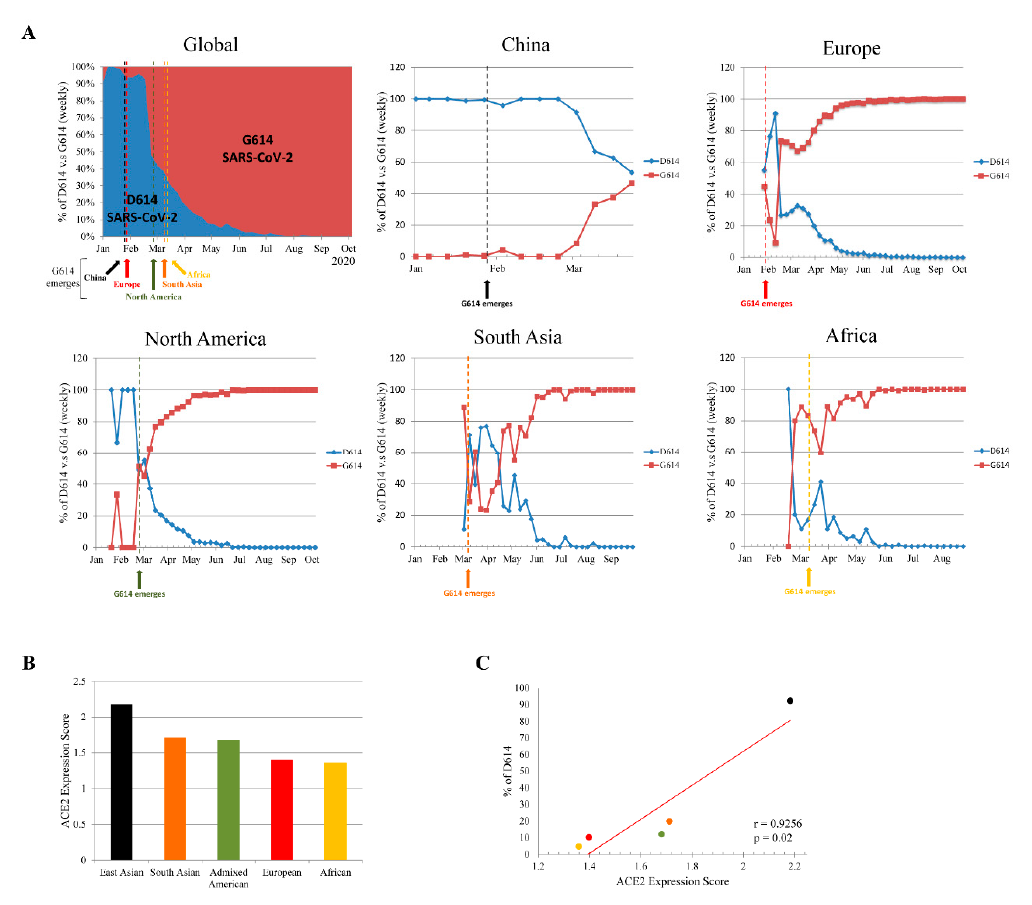
Figure 1. Transition of severe acute respiratory syndrome coronavirus 2 (SARS-CoV-2) spike (S) glycoprotein D614 to G614 variant in different geographic regions. ( A ) Weekly ratio of D614 and G614 variants globally, and in China, Europe, North America, South Asia, and Africa. Data analyzed from COVID-19 Viral Genome Analysis Pipeline (https://cov.lanl.gov/). ( B ) Angiotensin 1-converting enzyme 2 (ACE2) expression level in different geographical regions. ACE2 expression score analyzed by 21 ACE2 genetic polymorphisms that significantly affect its expression level according to the current study [18]. ( C ) Pearson’s correlation coefficient (r) and p value between ACE2 expression score and prevalence of D614 variants in different geographical